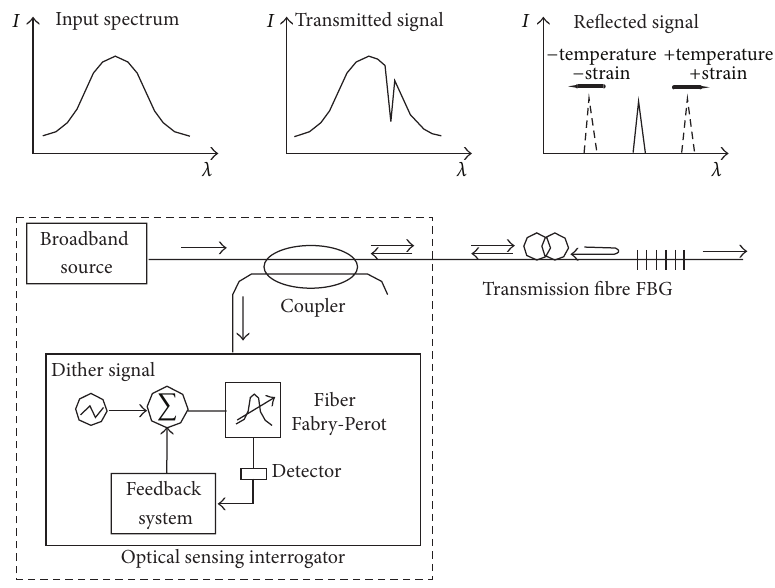
Figure 1: Strain and temperature sensing of an FBG